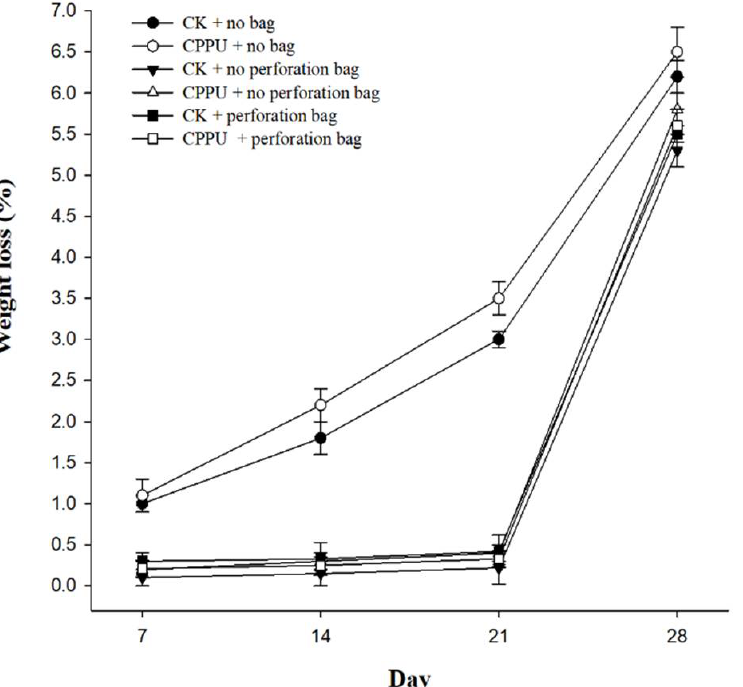
Figure 1. The effect of preharvest application of CPPU and perforation packaging on weight loss (%) at 5 ◦ C for 21 days and then removed to 20 ◦ C for 7 days. Bars represent means of four replications ± SD ( n = 4).